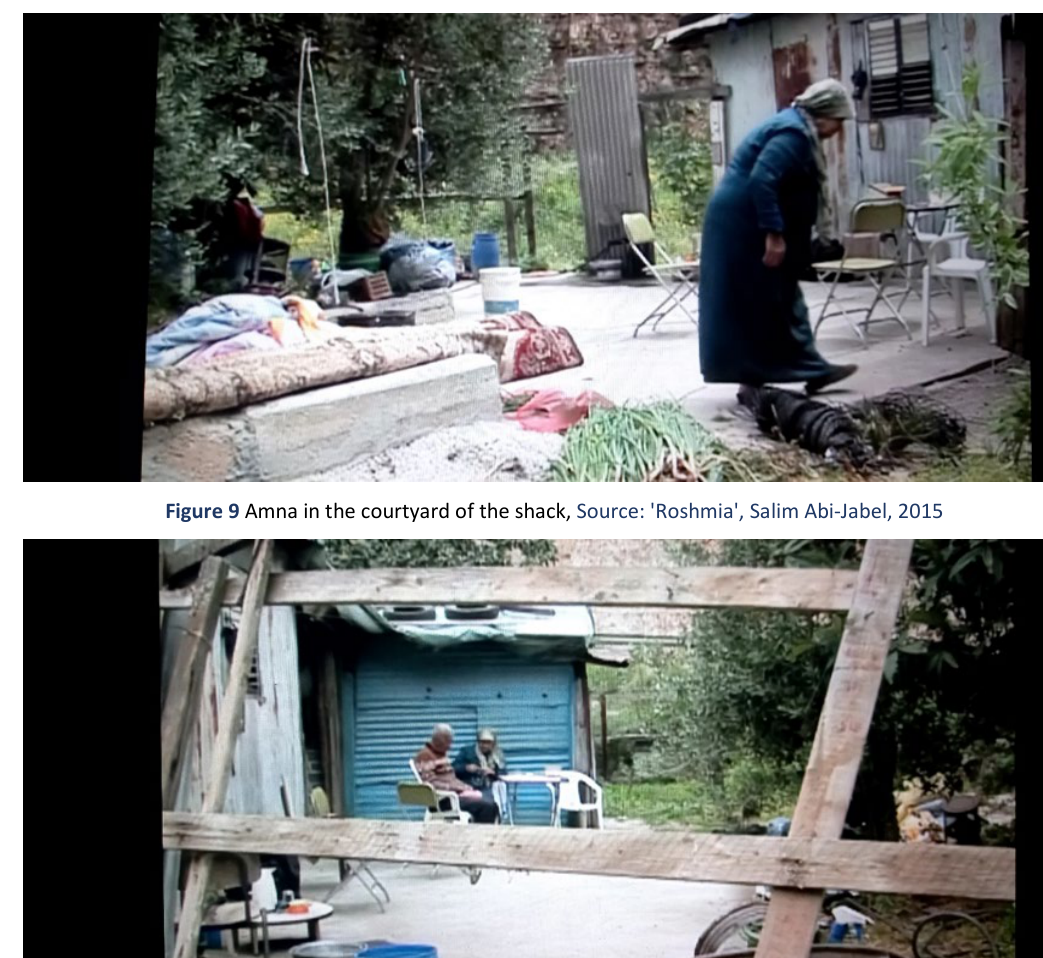
Figure 8 shack of Yousuf and Amna. Source: 'Roshmia', Salim Abi-Jabel, 2015